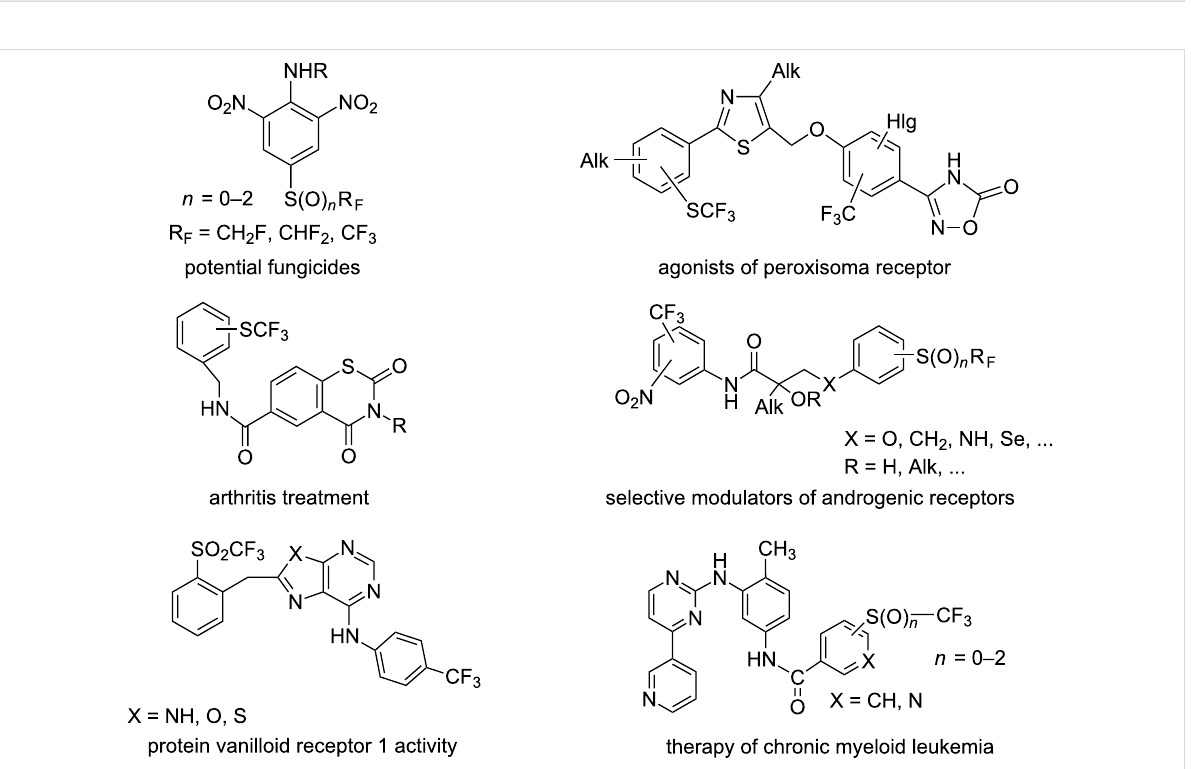
Figure 5: Recent examples of compounds containing R F S(O) n -groups